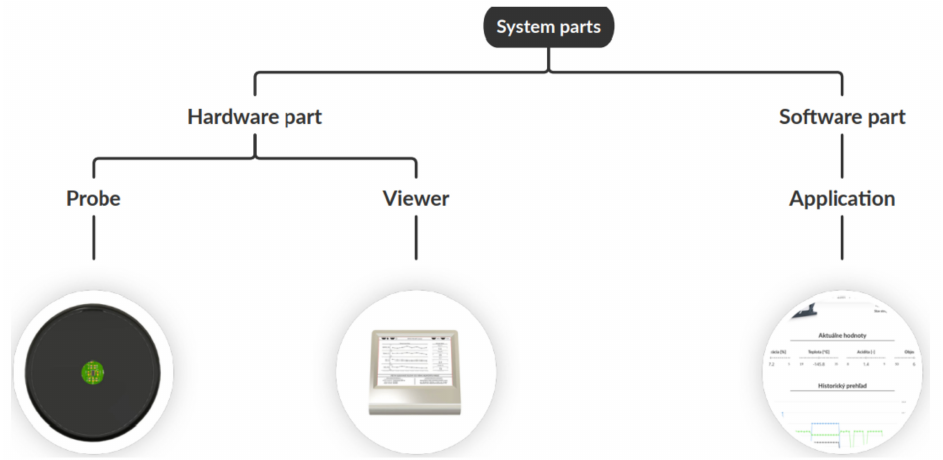
Figure 1. Scheme of monitoring system design